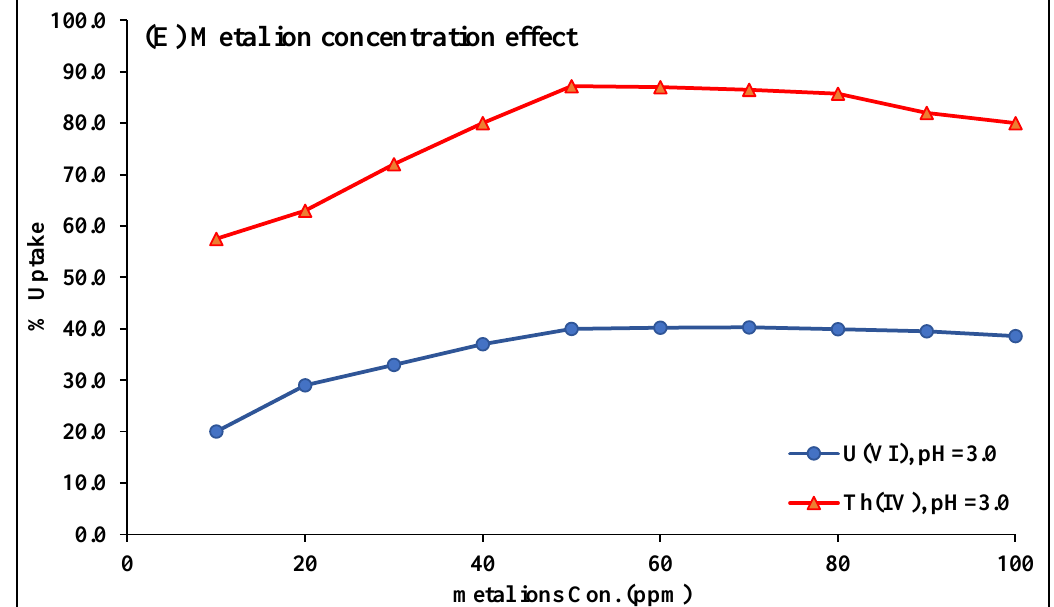
Figure 9. ( A ) Effect of (CCsMFO) nanocomposite mass for removal of U(VI) at pH 3.0 and Th(IV) at pH 3.0, T = 25 °C. ( B ) pH effect on U(VI)% uptake. ( C ) pH effect on Th(IV)% uptake. ( D ) Contact sorption time of metal ions on CCsMFO nanocomposite. ( E ) Metal ion concentration effect.